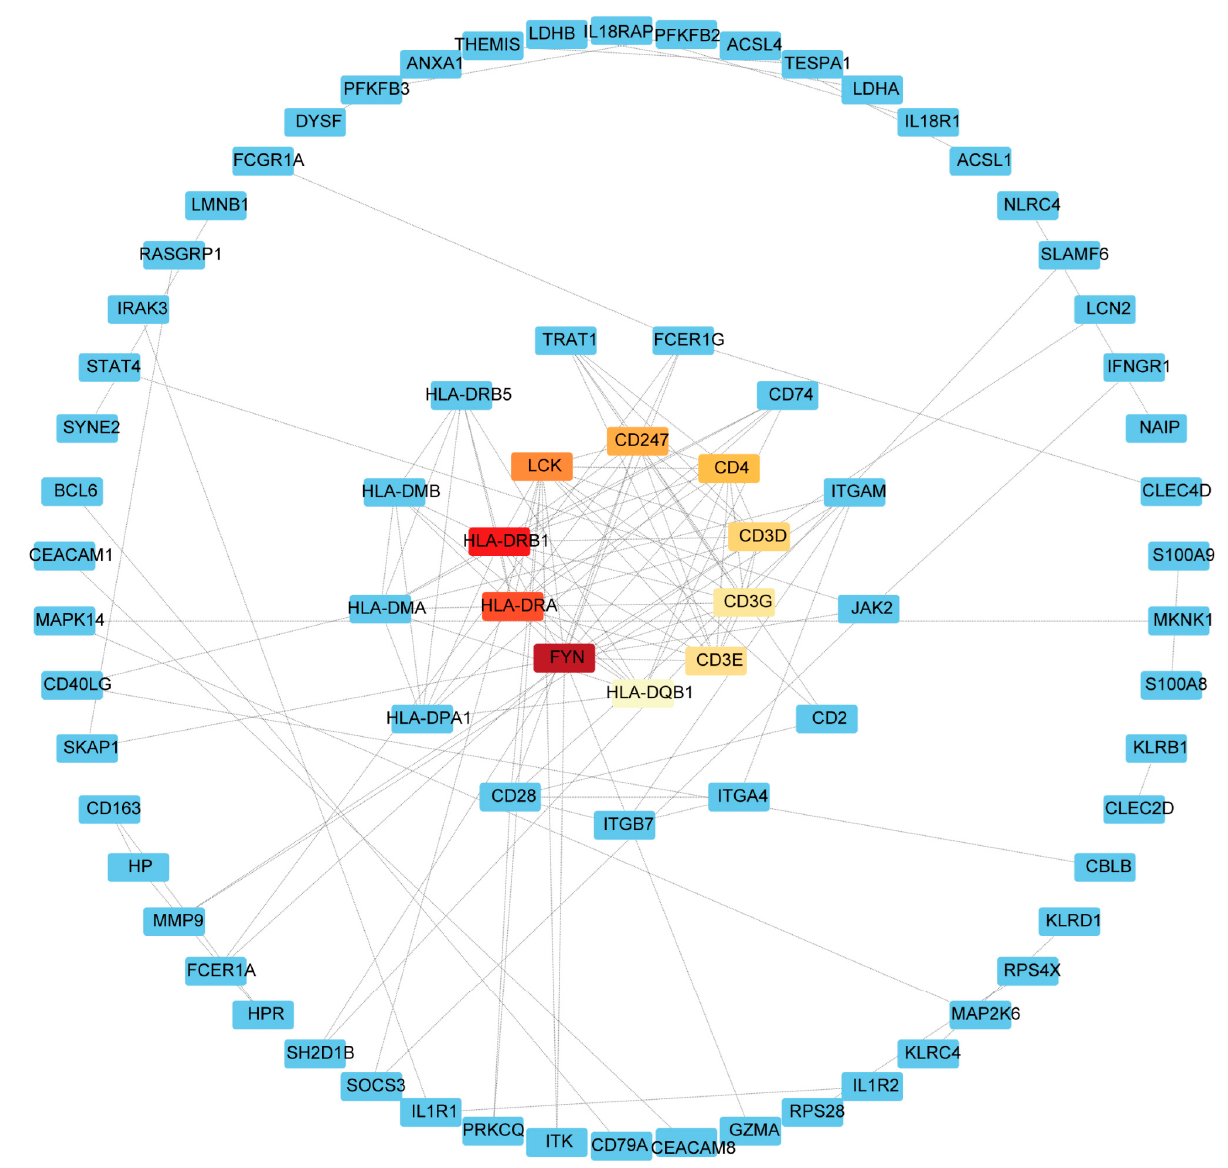
Figure 5. The hub gene in the PPI network was identified using the CytoHubba plug in Cytoscape. Red represents hub genes, darker colors represent hub genes ranked higher.